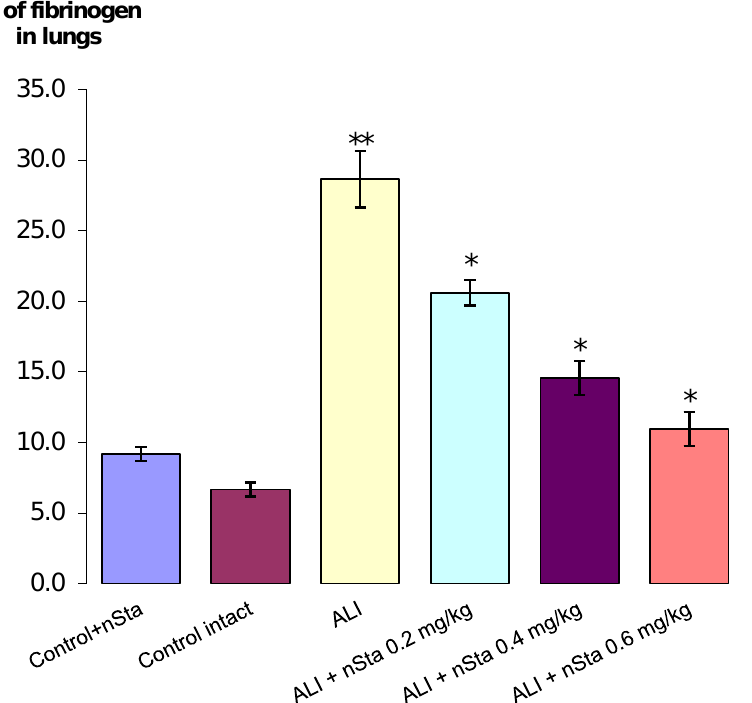
Figure 4. The percentage of fibrinogen-positive areas in the total area of lung tissue in the control, nontreated, and ALI groups after nSta 0.2 mg/kg, nSta 0.4 mg/kg, and nSta 0.6 mg/kg nebulization. Data are presented as the M ± SD. * p < 0.05 for ALI + nSta 0.2 mg/kg vs. ALI, ALI + nSta 0.4 mg/kg vs. ALI, ALI + nSta 0.6 mg/kg vs. ALI; ** p < 0.01 for ALI vs. Control Intact (ANOVA test with the Games – Howell post hoc test).